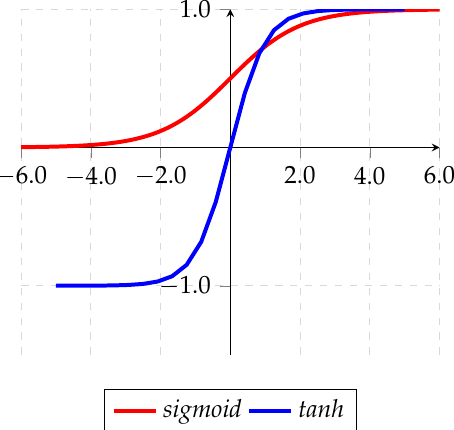
Figure 6. Sigmoid and tanh